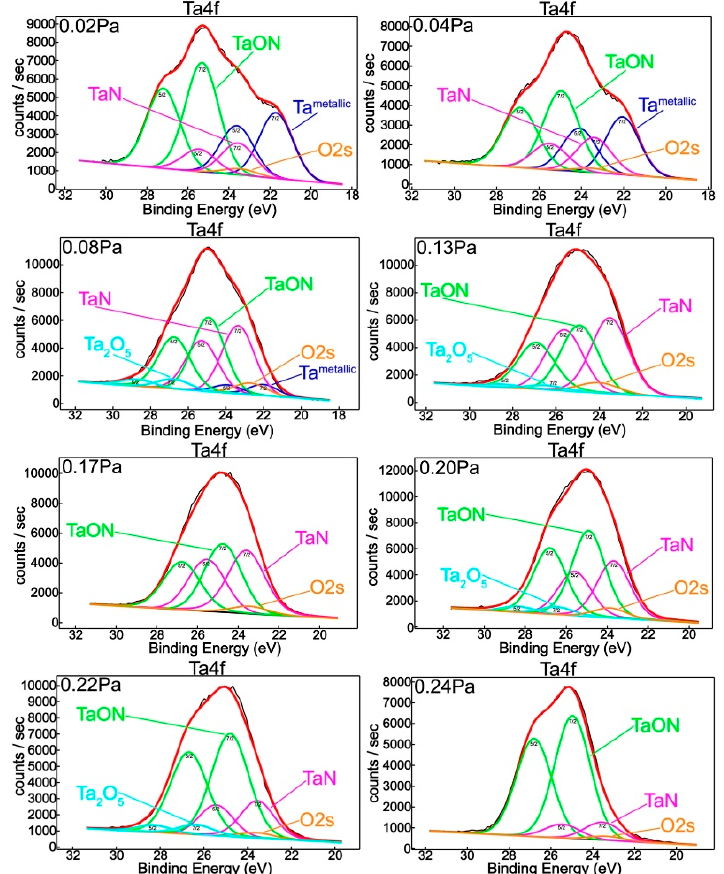
Figure 2. XPS deconvoluted Ta4f spectrum for samples obtained in different reactive gas mixture partial pressures.